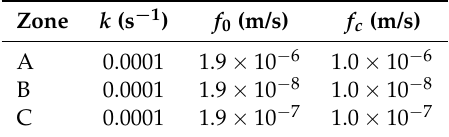
Table 1. Horton infiltration model